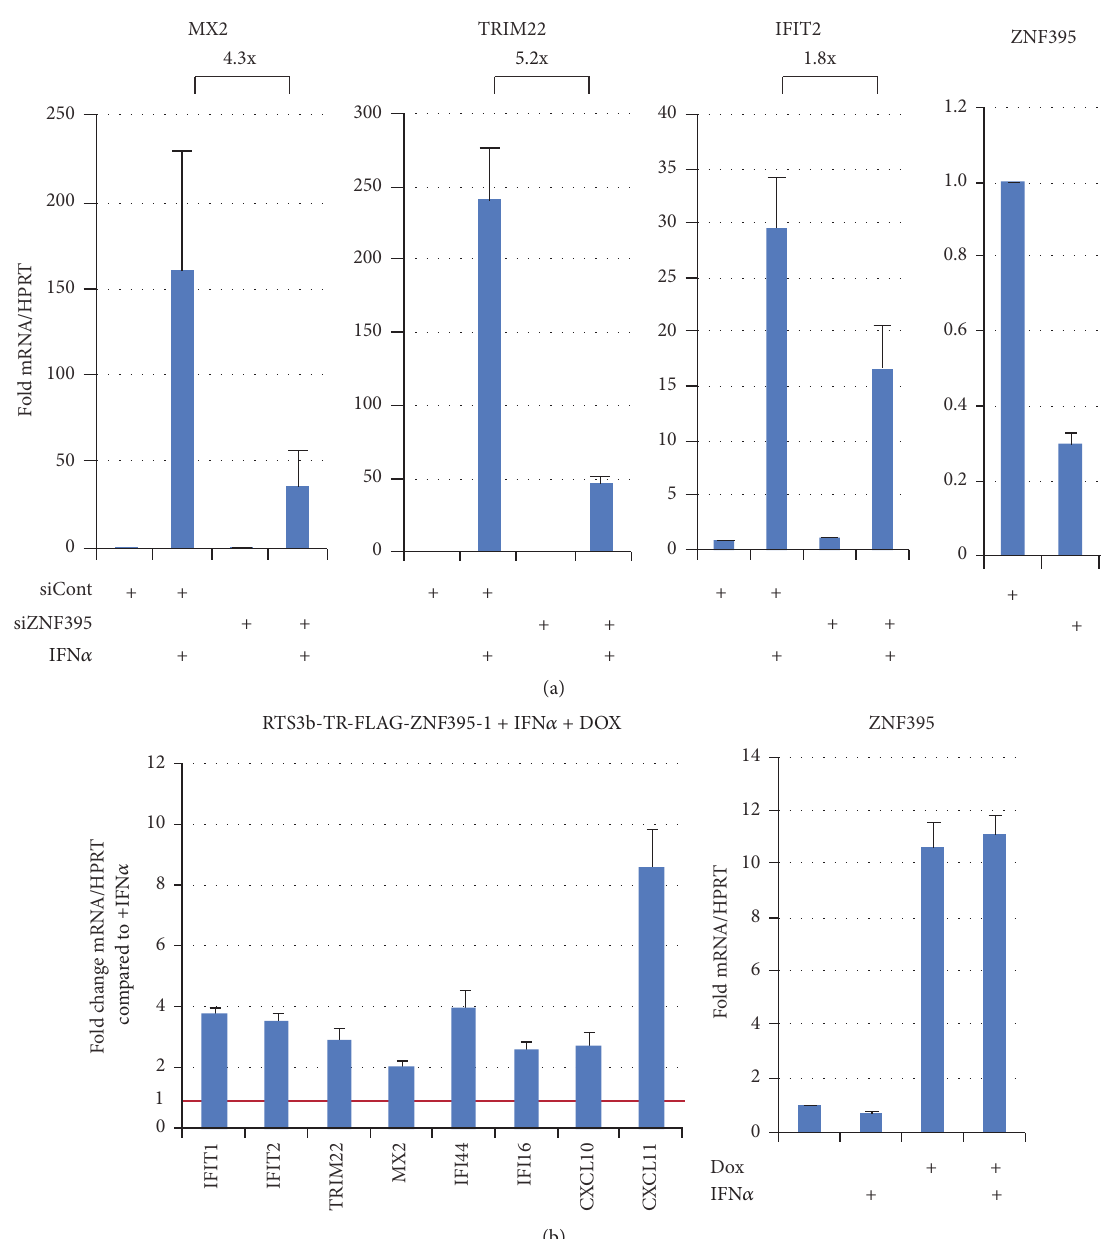
Figure 2: ZNF395 modulates the IFN 𝛼 -mediated induction of ISGs. (a) QRT-PCR with RNA from RTS3b cells that have been transfected with pooled siRNA against ZNF395 or control siRNA, and treated with 1000 U/ml IFN 𝛼 for 6 h as indicated. The RT-PCR results for MX2, TRIM22, and IFIT2 are shown. (b) The RTS3b-TR-FLAG-ZNF395-1 cell line, allowing the Dox-inducible overexpression of ZNF395, was treated with IFN 𝛼 . The fold changes of the factors in response to the addition of Dox compared to minus Dox, which was set as 1 in all cases, are given. The expression of ZNF395 was monitored by qRT-PCR in RTS3b cells after transfection with pooled siRNA against ZNF395 or siControl and in the RTS3b-TR-FLAG-ZNF395-1 line, in the presence and absence of Dox. In all cases, the CP-values have been normalized against those for the house keeping gene HPRT. Fold changes were calculated by Δ -threshold method [40]. RT-PCR results are the means of three to six independent assays. Standard deviations are